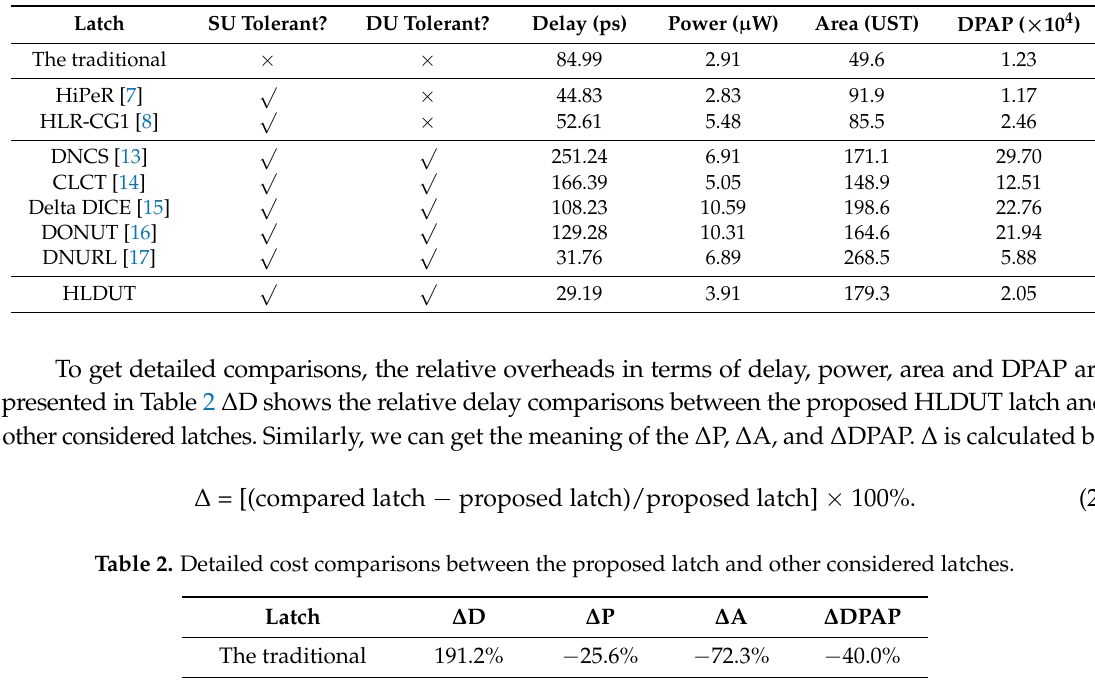
Table 1. Cost comparisons of all considered latches.